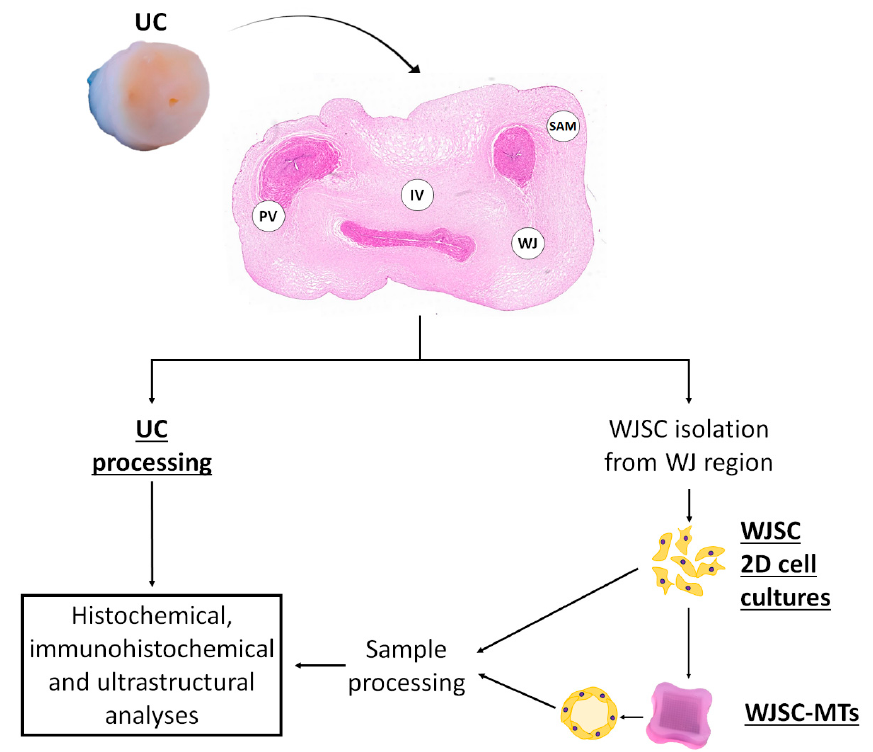
Figure 1. Flow chart of the experimental procedures applied to umbilical cord in this study. A rep- resentative image of an agarose microchip is shown at the bottom of the image. UC: umbilical cord; SAM: sub-amnion; WJ: Wharton’s jelly; IV: intervascular and PV: perivascular region; WJSC-MTs: Wharton’s Jelly stem cell-derived microtissues.